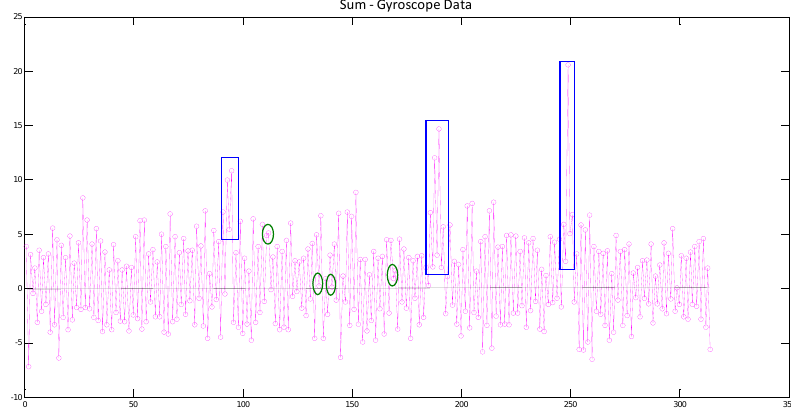
Figure 12. Analysis of the accumulated gyro value.